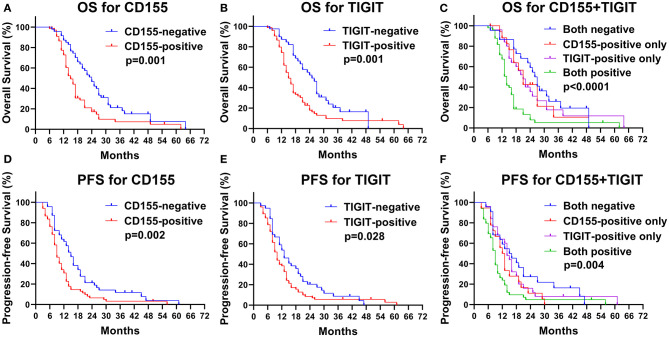
Kaplan-Meier curves of OS for CD155 (A) and TIGIT (B) expression and their combination (C). Kaplan-Meier curves of PFS for CD155 (D) and TIGIT (E) expression and their combination (F).